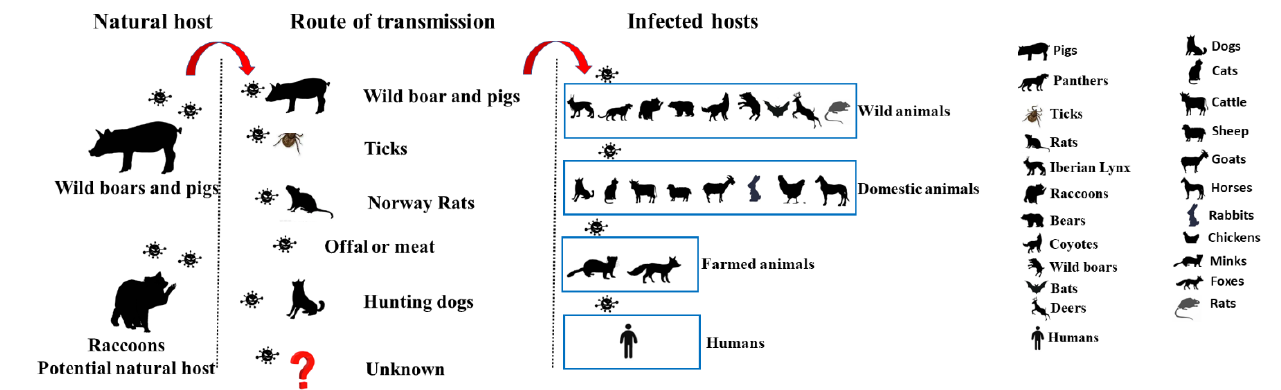
Figure 1. Schematic of PRV transmission. Wild boars and pigs are natural hosts of the PRV, while raccoons are potential natural hosts of the PRV. Five known transmission routes are described. Infected hosts include humans and wild, domestic, and farm animals.